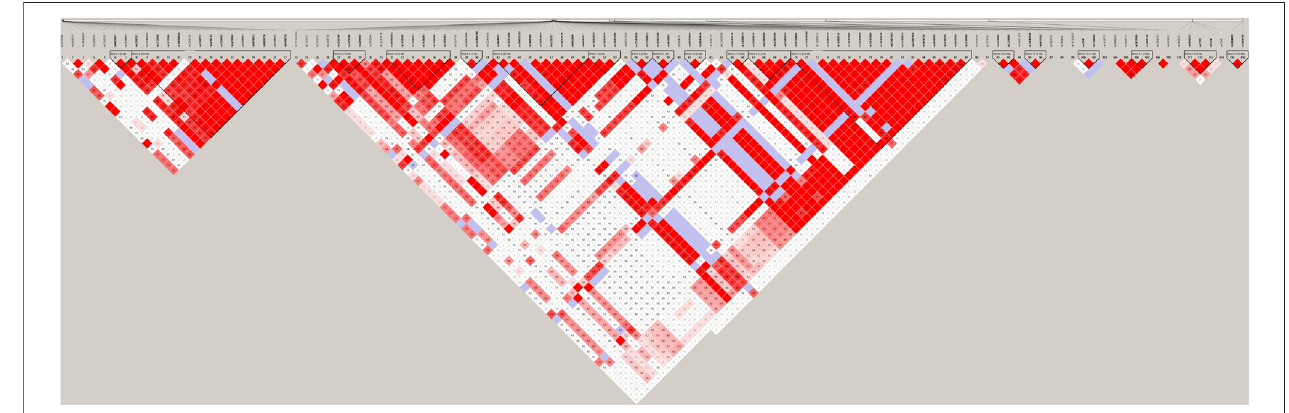
FIGURE 2 | LD results of detected SNPs in the TLR2 gene. Abbreviation: LD, linkage disequilibrium; SNPs, single-nucleotide polymorphisms.